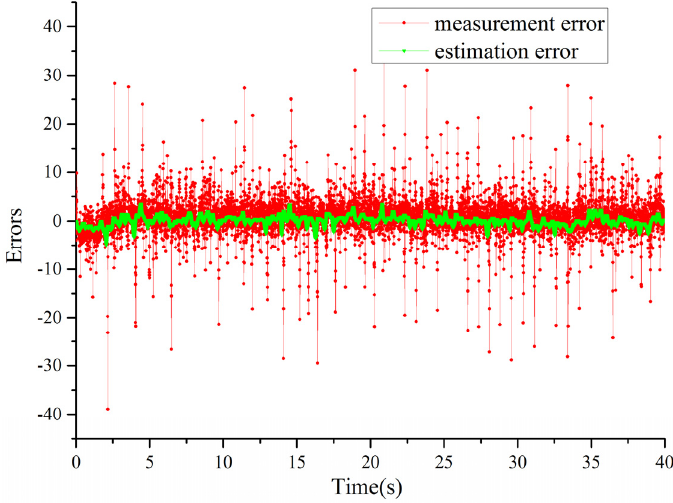
Figure 11. Estimation error.